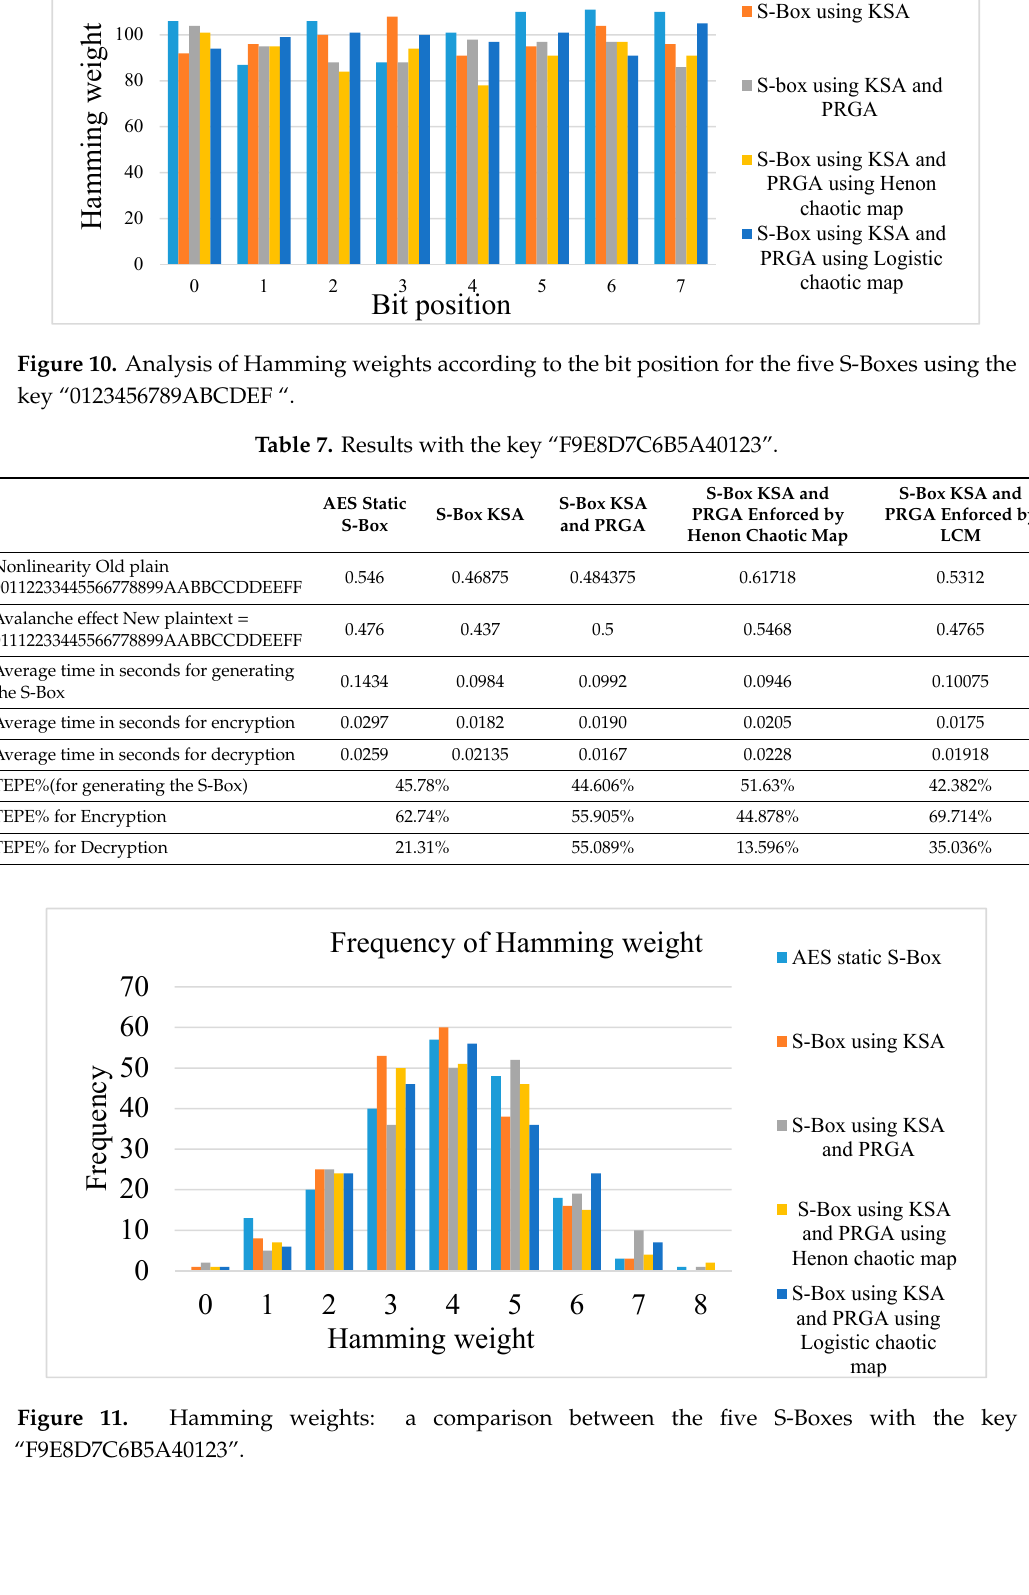
Figure 9. Analysis of the frequency versus differential values, ∆ Y, for the 5 S-Boxes with the key “0123456789ABCDEF .